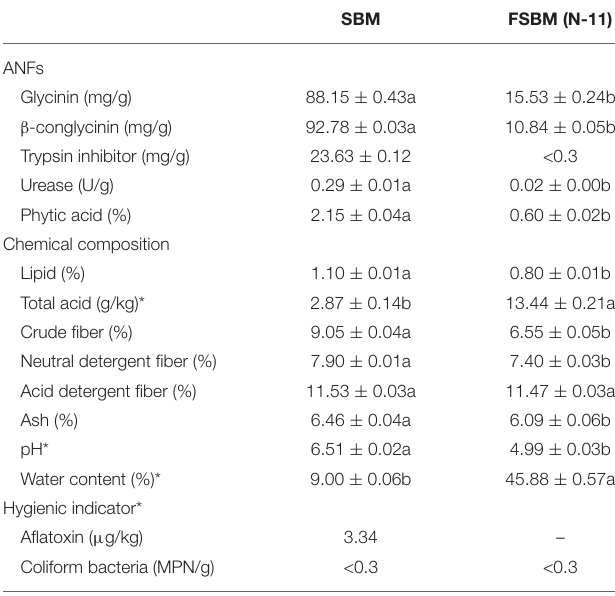
TABLE 1 | Anti-nutritional factors (ANFs), chemical composition, and hygienic indicators in SBM and